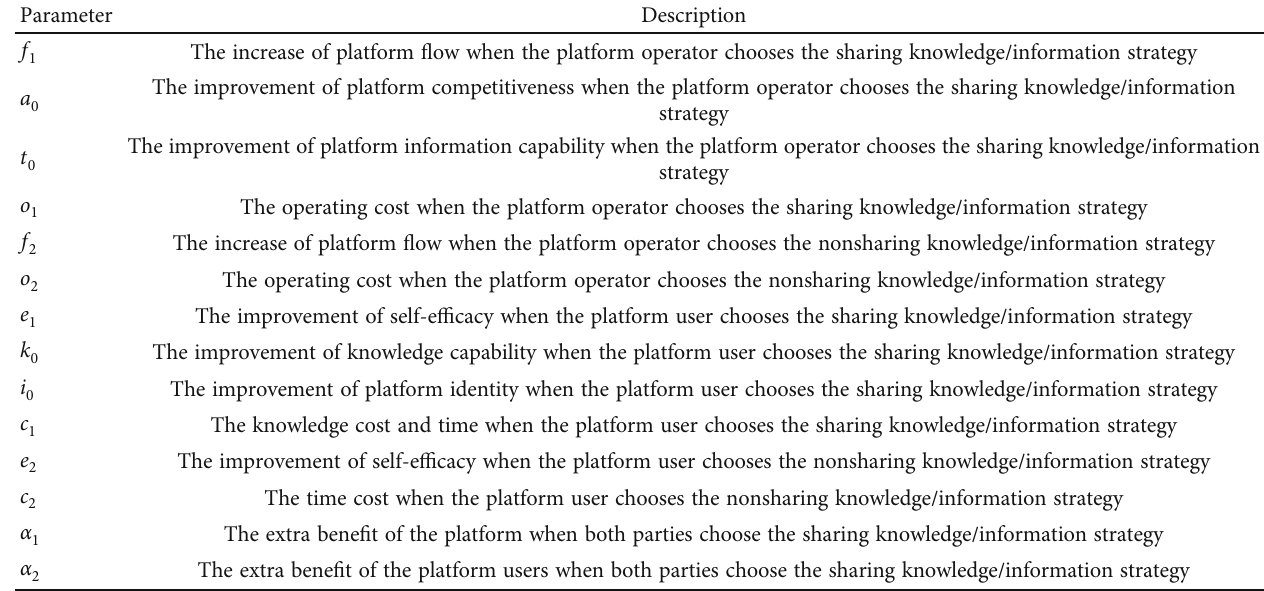
Table 1: Parameter description.